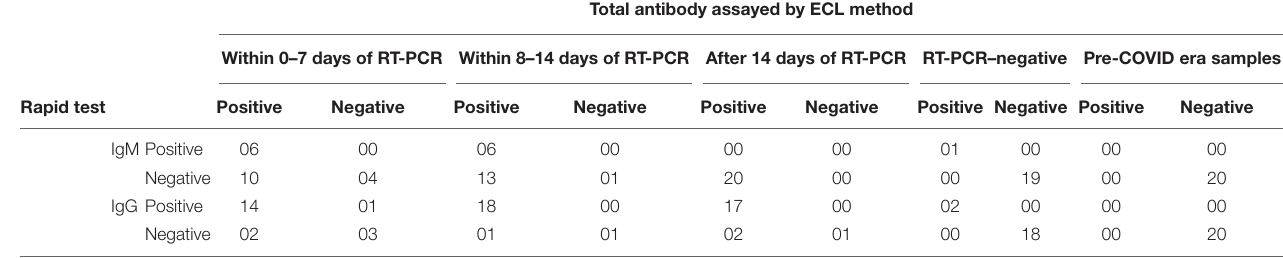
TABLE 4 | Table showing distribution of positive and negative antibody test results by rapid test kit and ECLIA method on samples collected from COVID patients at 0–7, 8–14, and after 14 days of RT-PCR–positive and RT-PCR–negative subjects and pre-COVID samples. Total antibody assayed by ECL method